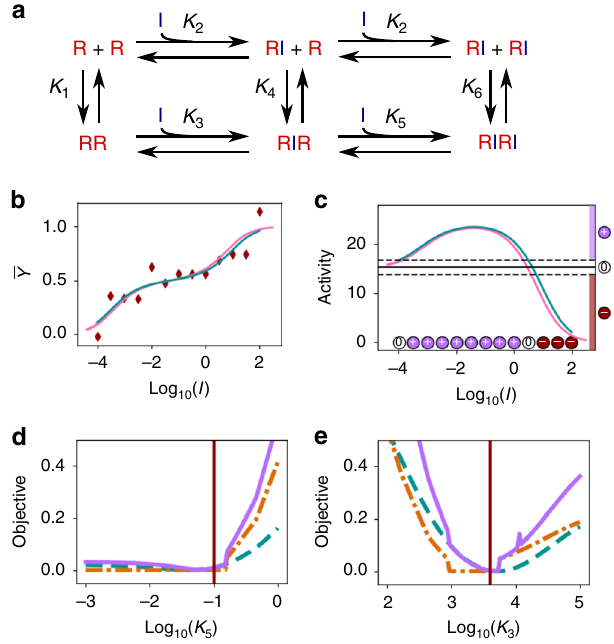
Fig. 2 A model of Raf inhibition. a Reaction network. Raf (R) can dimerize, and each monomer can bind an inhibitor (I). b Synthetic quantitative data (dark red diamonds) of the free inhibitor concentration I (in μ M) versus the proportion of Raf bound to inhibitor Y . c Synthetic qualitative data of free inhibitor concentration I versus Raf activity. We assume Raf activity is proportional to RR + RIR, but the data (circles on x -axis) only tell us whether the activity is higher ( + ), lower ( − ), or within error (0) of the activity at I = 0. In b , c magenta curves indicate the ground truth, and blue curves indicate the best fi t using the combined qualitative and quantitative datasets. Curves in c show the quantitative value of RR + RIR. d , e Pro fi le likelihood uncertainty quanti fi cation of the two unknown parameters of the model, K 3 and K 5 , using the quantitative data in b (blue dashed curve), the qualitative data in c (orange dash-dot curve) or both datasets combined (purple solid curve). Vertical red lines indicate the ground truth values. Vertical axes indicate the relative objective function values, obtained by normalizing each pro fi le to zero by subtracting its minimum